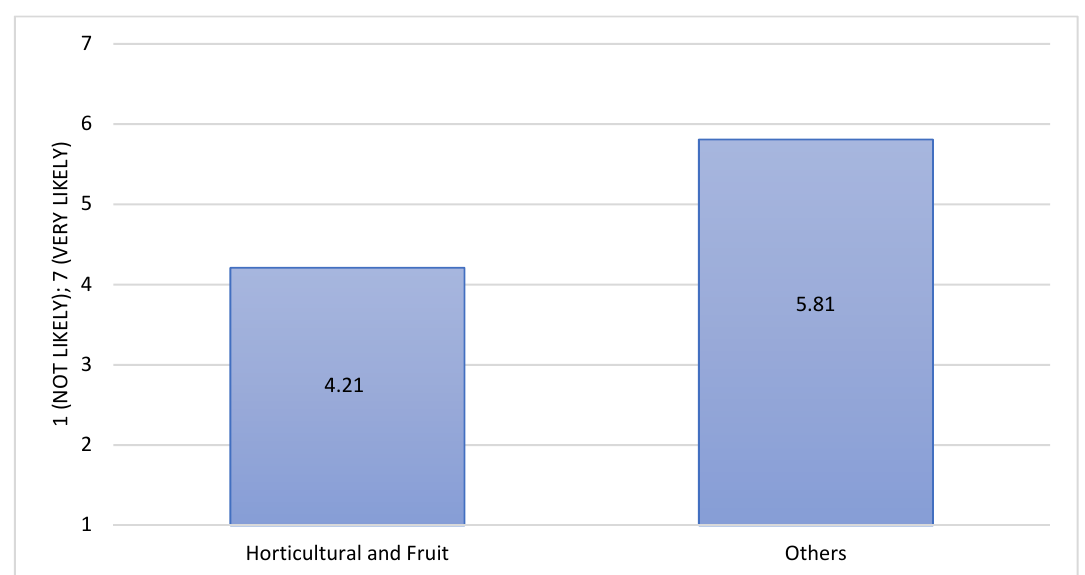
Figure 8. Probability of adopting agroecological practices depending on the sector that the farmers belong to.